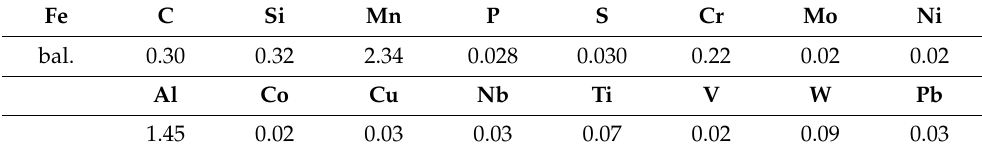
Figure 1. Microstructure ( a ) and hardness curve HV 0.1 of CP1000 along the sheet thickness ( b ) adopted from [21]. Table 1. Chemical composition of the sheet material measured via OES given in wt.%.